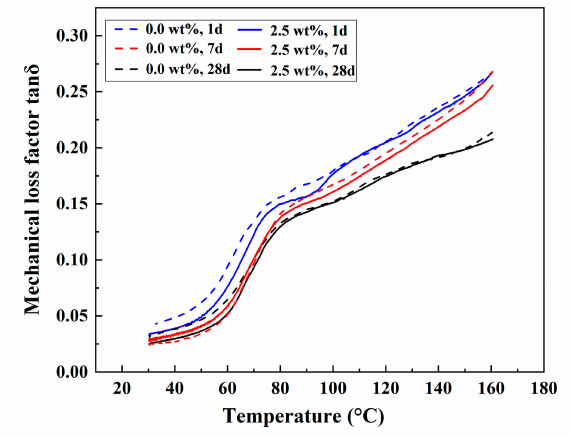
Figure 10. The relationship between loss factors and temperatures of PU, PU / MFA-0.0 wt. %, and PU / MFA-2.5 wt. % specimens at di ff erent curing